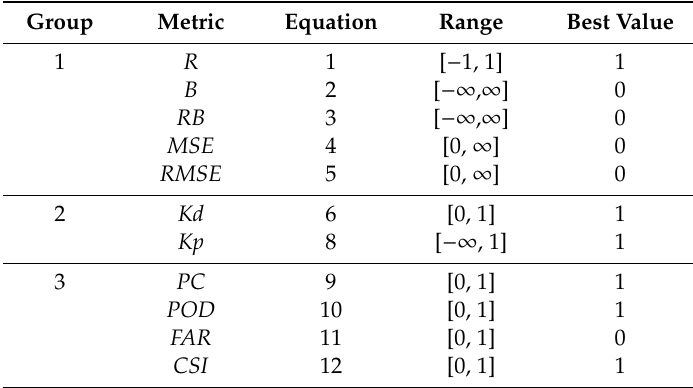
Table 1. Details of the evaluation